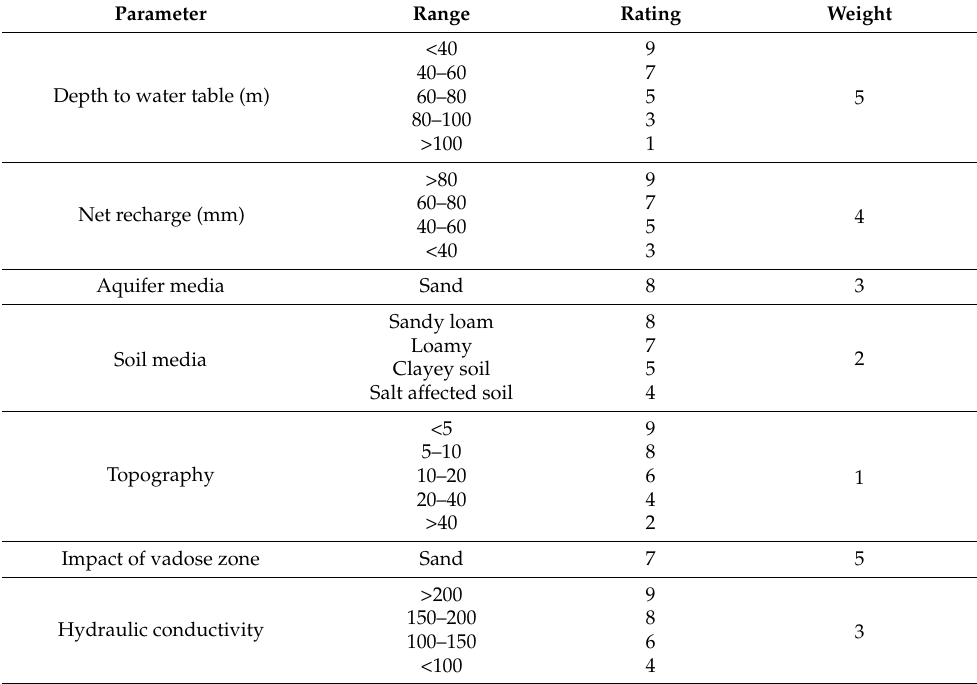
Table 2. Weights and ranges allocated to various factors used in the contamination vulnerability assessment